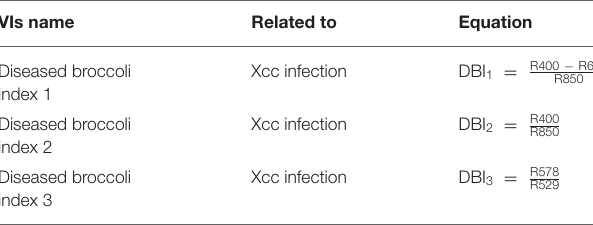
TABLE 4 | Novel vegetation indices (VIs) firstly described in this